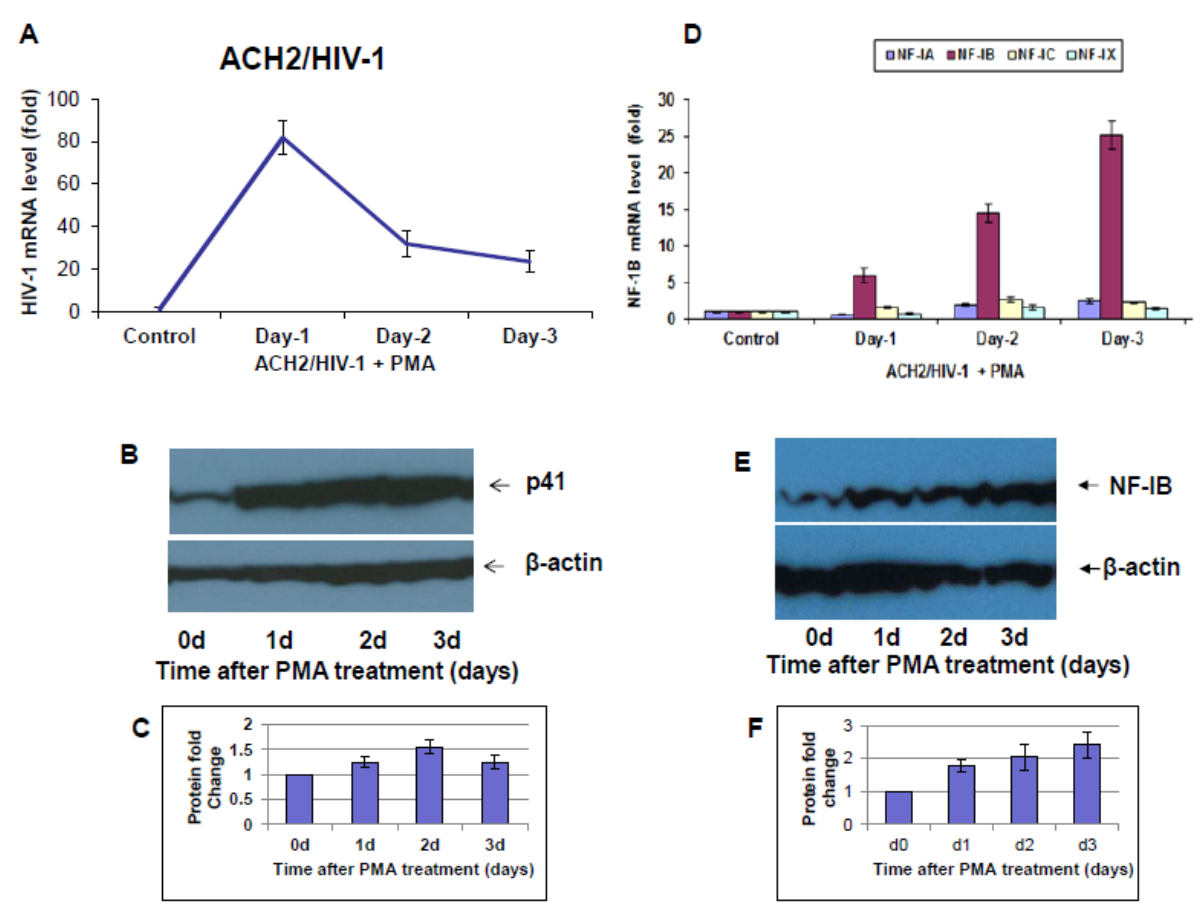
Figure 3. HIV-1 and NF-IB levels during re-activation of ACH2/HIV-1 cells. ACH-2 cells were stimulated with phorbol 12- myristate 13-acetate (PMA) for four days. At the indicated time point, cells were harvested to measure HIV-1 ( A , B ), and NF-IB ( D , E ) levels by both qRT-PCR and Western blotting, respectively. The data in Figure 3A,D were normalized to GAPDH levels and represent the mean ± SEM from three experiments . ( C , F ). Quantification of signals from Western blots was done using Image J software. Fold change is relative to the 0 d time point. Data are averages of Western blot quantifications ± SEM. Representative Western blots are